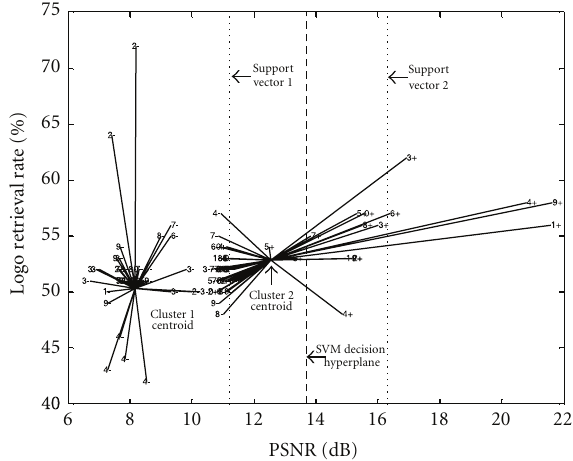
Figure 8: SVM classification and K -means clustering results by the DCTMSB approach of the proposed MSB-based scheme. Note that the distance between support vectors by SVM [27] is d = 31 . 3 and cluster 1 and cluster 2 are positive and negative clusters, respectively, by K -means clustering algorithm [28]. Attack numbers 0–9 are referred using Table 3.